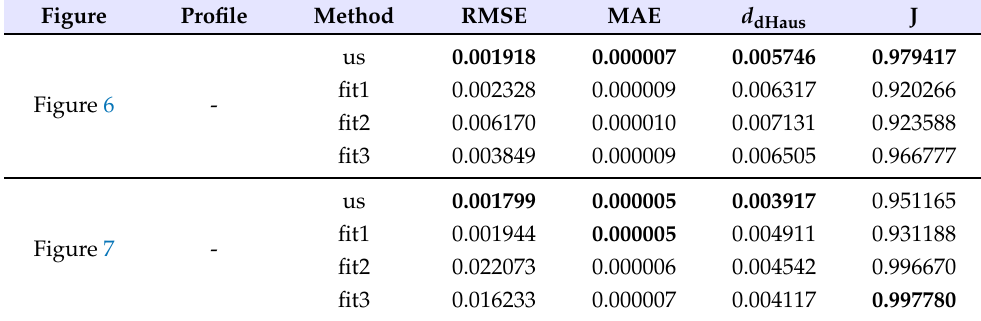
Table 1. Indicators for the examples in Figures 6 and 7. For each profile, we report: the Root Mean Squared Error (RMSE), the Mean Absolute Error (MAE), the normalized directed Hausdorff distance d dHaus and the Jaccard index J . Here, fit1, fit2 and fit3 stand, respectively, for quadratic polynomial, piecewise cubic and smoothing spline fitting. For each figure and each indicator, the best performance is reported in bold.